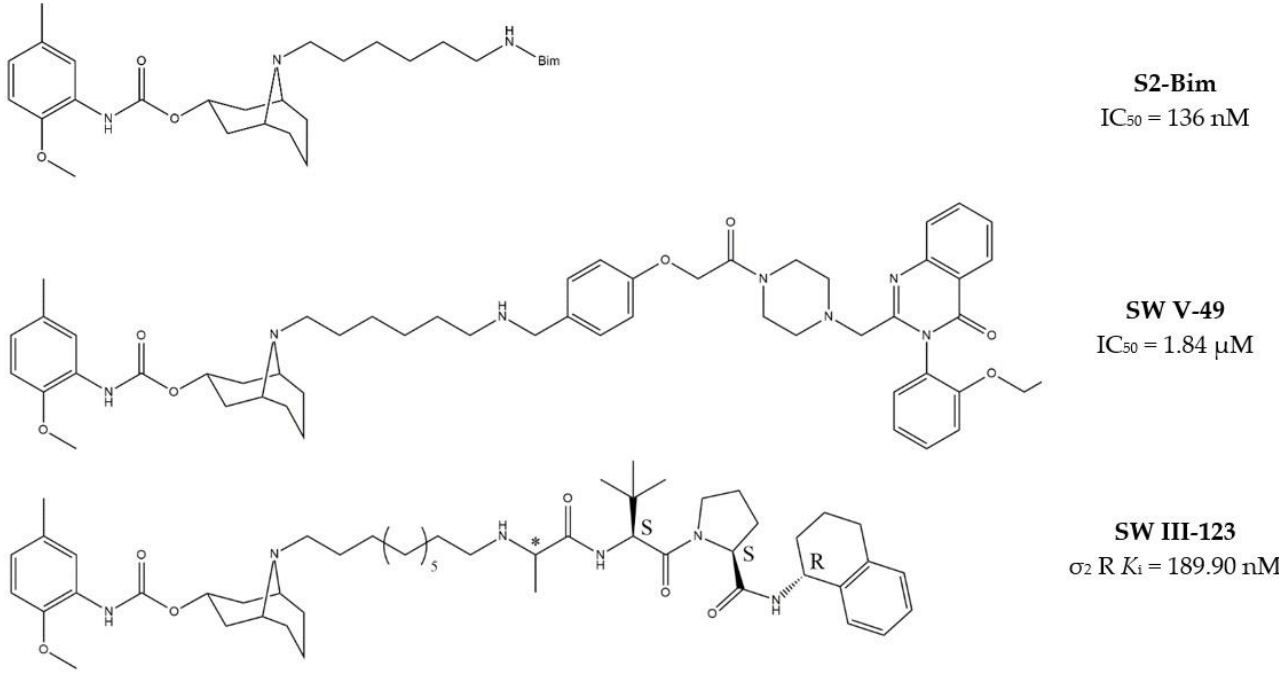
Figure 4. Granatane-based MTDLs: S2-Bim (peptide sequence: EIWIAQELRRIGDEFNAYYAR-OH), SW V-49 and SW III-123 structures and biological data.